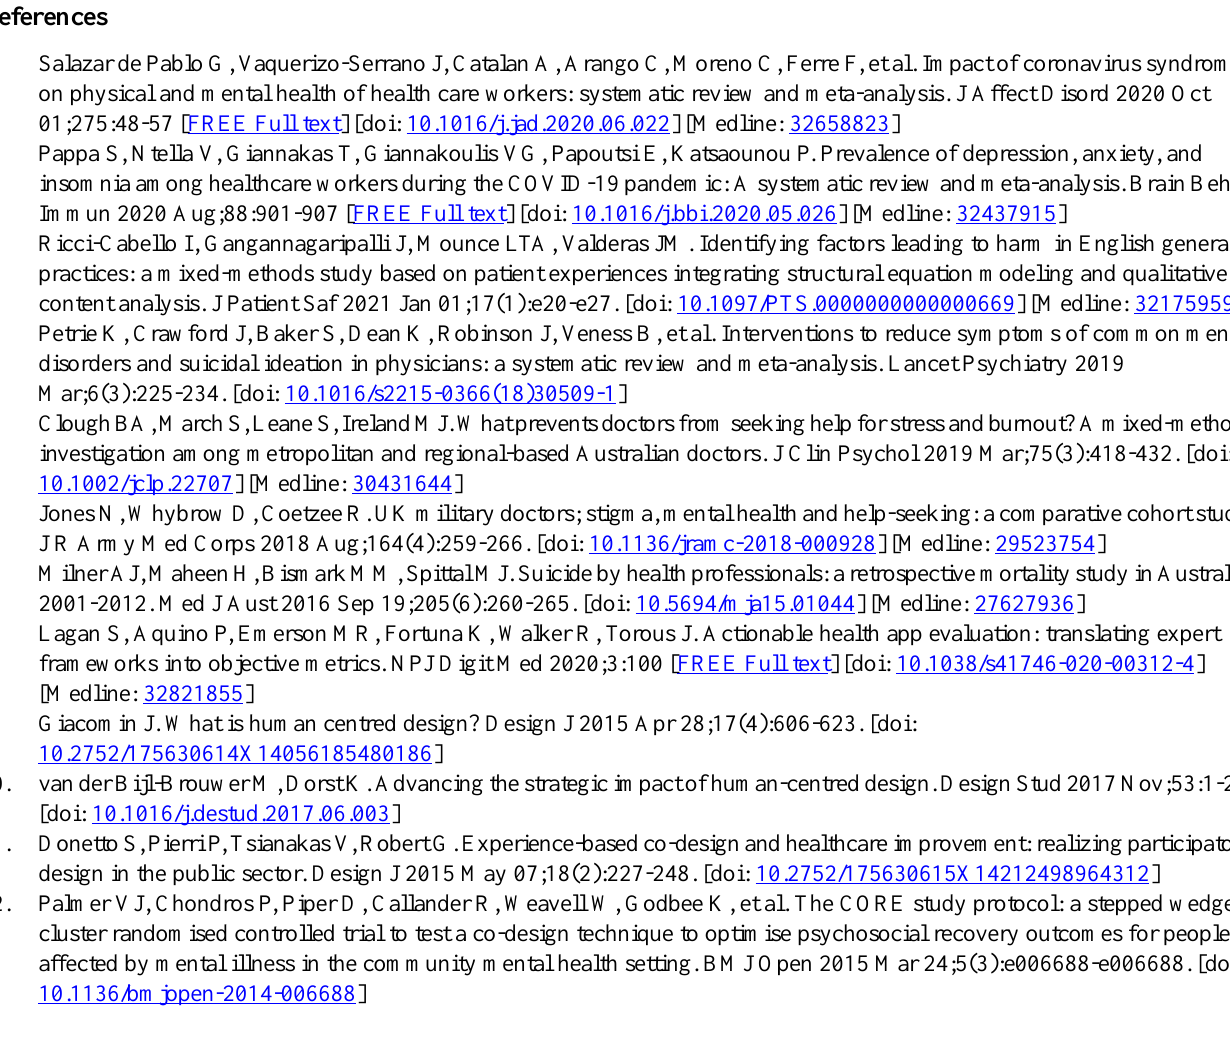
Supplementary table: overview of the user analytics plan. [DOCX File , 13 KB-Multimedia Appendix